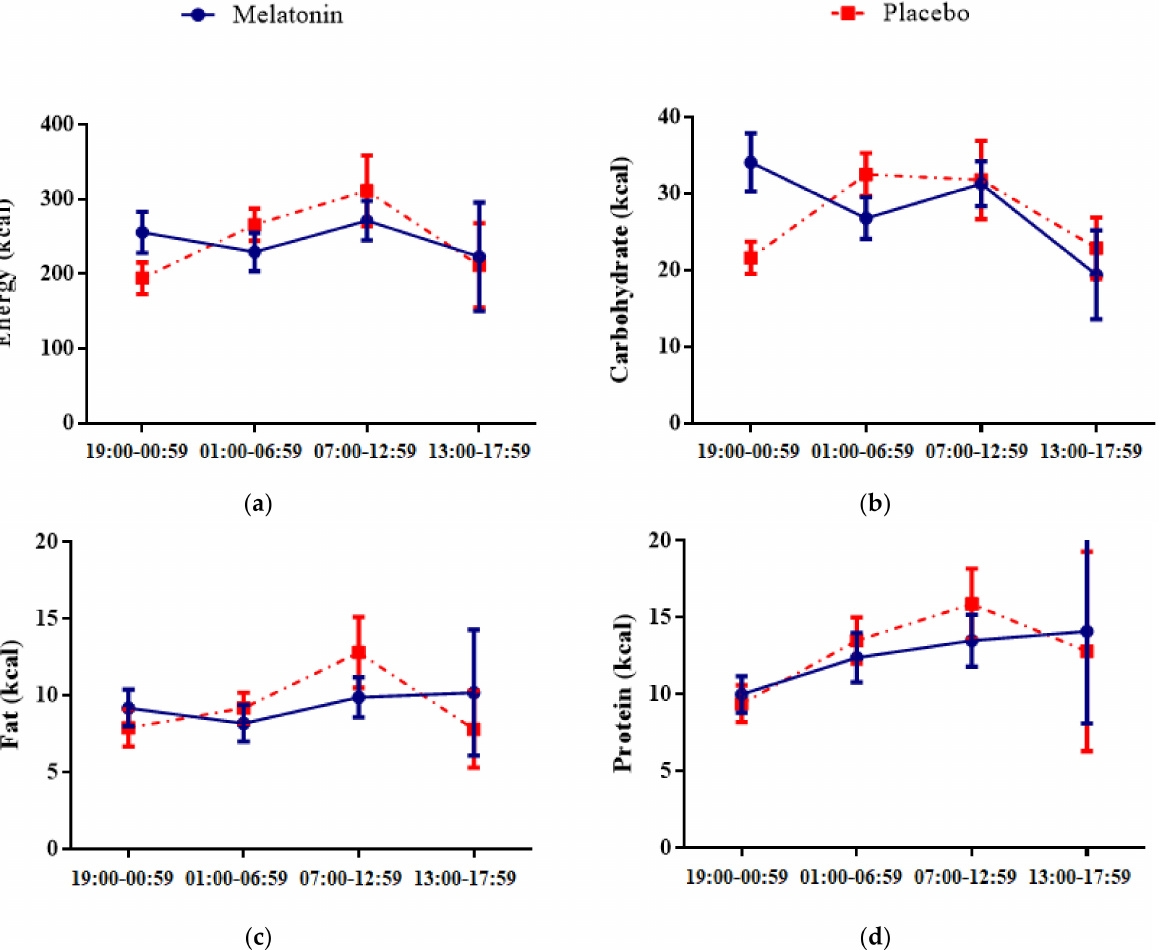
Figure 2. Temporal distribution of food intake after melatonin and placebo administration. Vertical lines represent standard error of mean. ( a ) Energy, ( b ) Carbohydrate, ( c ) Fat, and ( d )